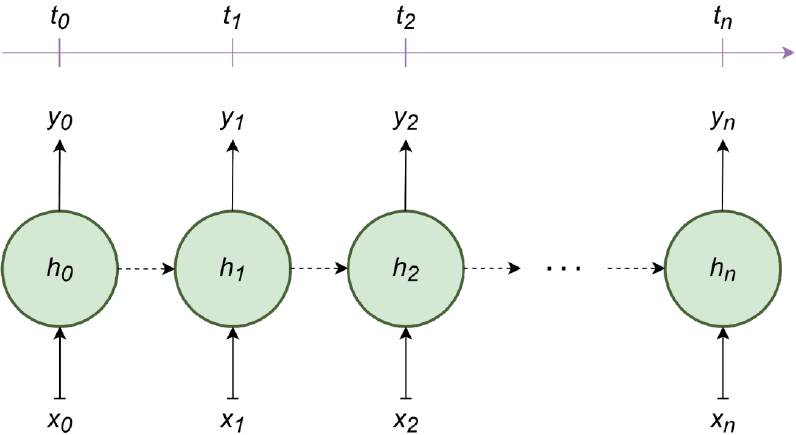
Figure 1. RNN computational graph across the time. t i represents different time points in which the RNN for a given input x i and current state h i produces the output y i .